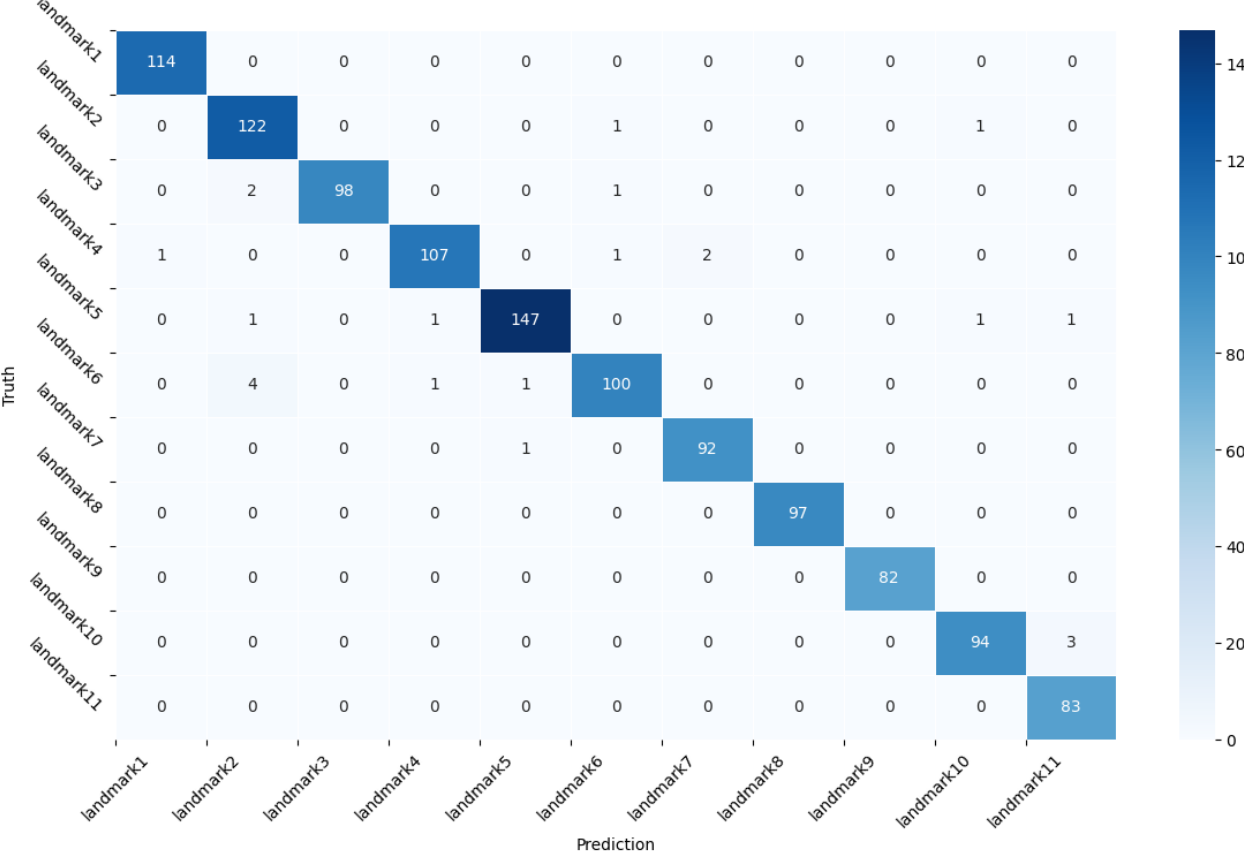
Figure 6. Confusion matrix for landmark identification.